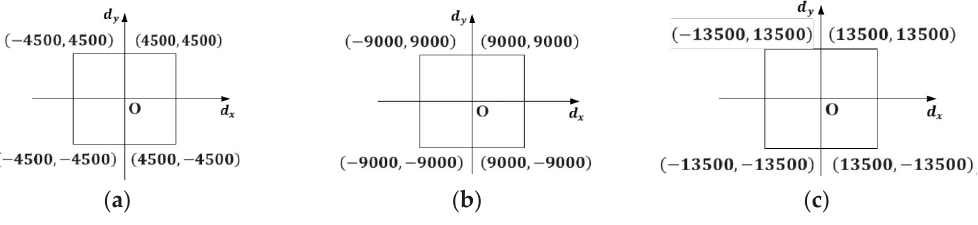
Figure 8. Error distribution of the input digital voltages.